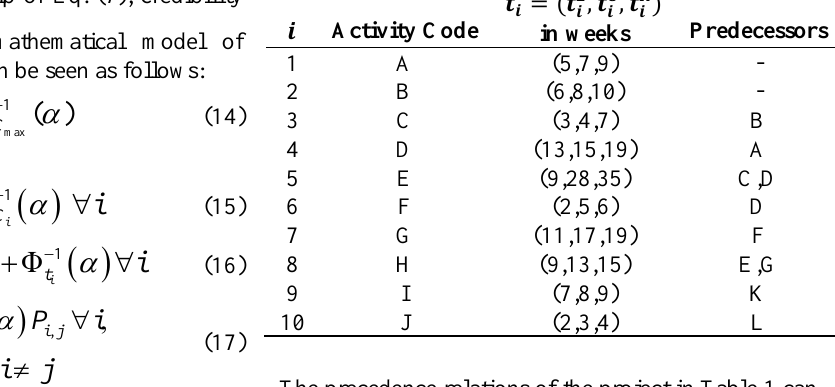
Table 1. Comparison of the mean-field predictions